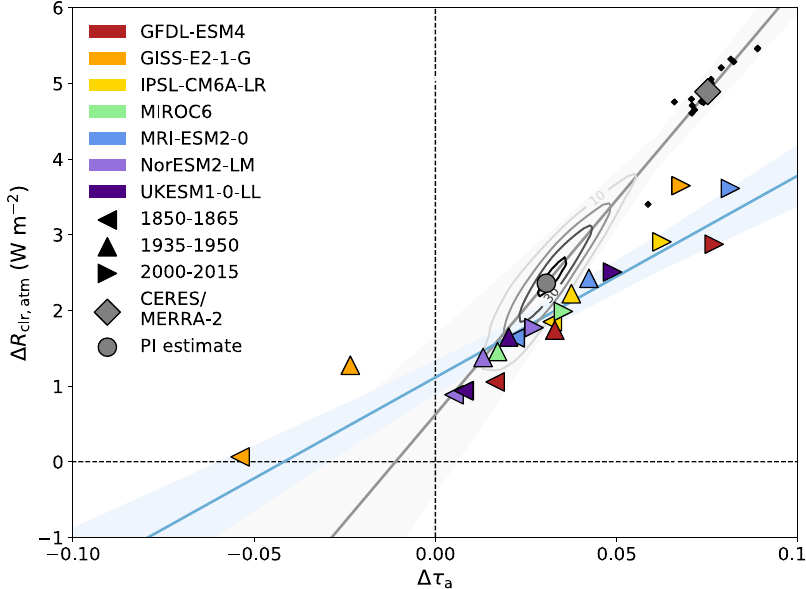
Fig. 3 Relationship between the hemispheric aerosol and atmospheric re fl ection asymmetries in the preindustrial, midcentury, and present-day. CMIP6 model values of the hemispheric asymmetries in aerosol optical depth ( Δ τ a ) and clear-sky atmospheric re fl ection ( Δ R clr,atm ) from the historical runs are represented as colored triangles (facing left for the 1850 – 1865 mean, up for 1935 – 1950, right for 2000 – 2015; red for GFDL-ESM4, orange for GISS-E2- 1-G, yellow for IPSL-CM6A-LR, green for MIROC6, blue for MRI-ESM2-0, indigo for NorESM2-LM, and violet for UKESM1-0-LL) and their regression fi t and its 95% con fi dence interval are represented by the blue line and shading. CERES/MERRA-2 data are represented as a gray diamond for the modern mean and as smaller black diamonds for individual years. The regression fi t between individual CERES/MERRA-2 years and its 95% con fi dence interval is represented by the gray line and shading. Contours represent kernel density estimates of the Monte Carlo probabilities (shown every 10 counts) for calculating the preindustrial value of Δ R clr,atm , with the gray circle representing the mean